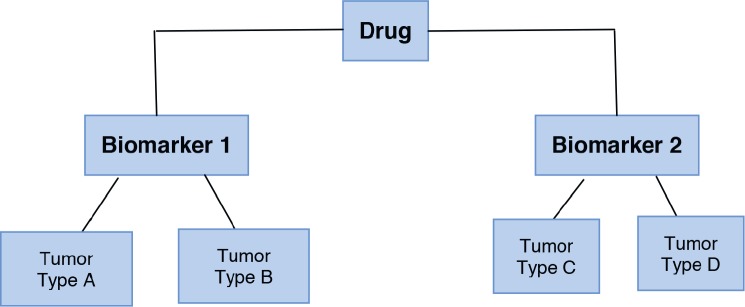
Basket trial design.